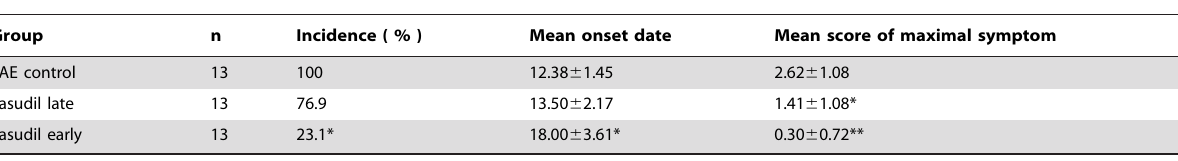
Fasudil was injected (i.p.) at 40 mg/kg/d every other day on day 3 p.i. (Fasudil early treatment) and on day 11 p.i. (Fasudil late treatment). The injection of normal saline was set up as control (EAE control) in a similar manner. Data are presented as mean 6 S.E.M. * p , 0.05, ** p , 0.01.